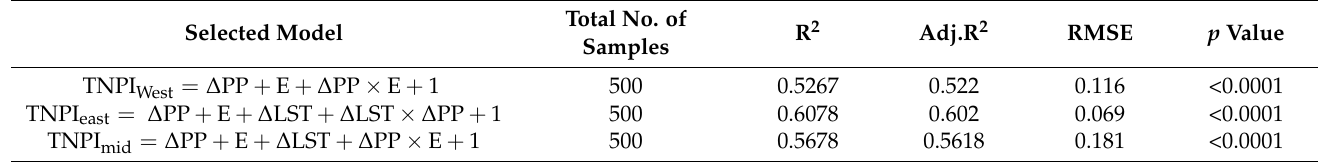
Table 4. The final selected models and their performances for three forest zones using Sentinel-2 NDVI data. TNPI west , TNPI east , and TNPI mid represent the vegetation growth model for western, eastern, and middle forest zones, respectively, as described in Section 2.2.9. Total No. of Selected Model R 2 Adj.R 2 Samples